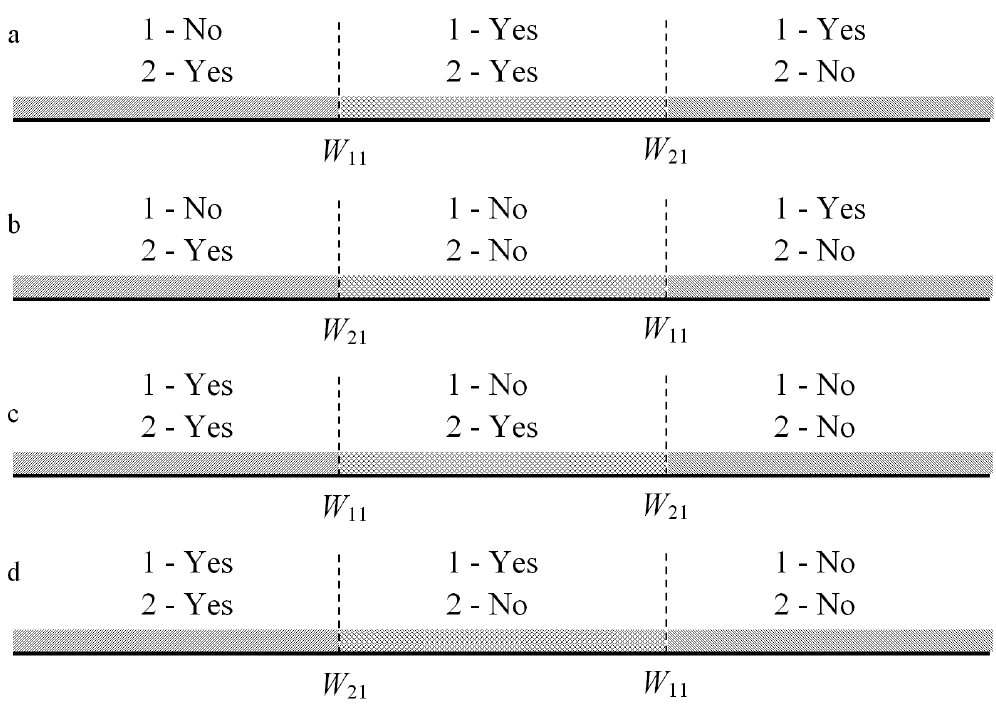
Figure 2. Scheme explaining the various options for the conflict situation shown in Figure 1, when parameter 𝐻 (cid:2869) is changed by participant 1: ( a )–situation A 11 ; ( b )–situation A 12 ; ( c )–situation A 21